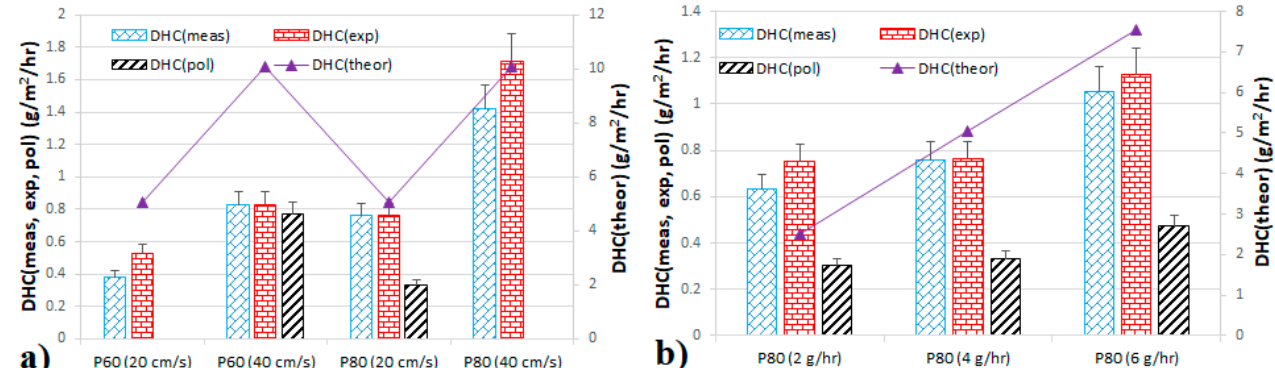
Figure 6. Dust-holding capacity per cake pressure drop of different membranes at different permeate velocities at a constant loading rate of 4 g/h ( a ) and P80 membrane at 20 cm/s at different loading rates ( b ), DHC measured ( DHC meas ), DHC from exponential fit ( DHC exp ) and DHC from polynomial fit ( DHC pol ) are at the major axis, DHC theoretical ( DHC theor ) is at the minor axis.